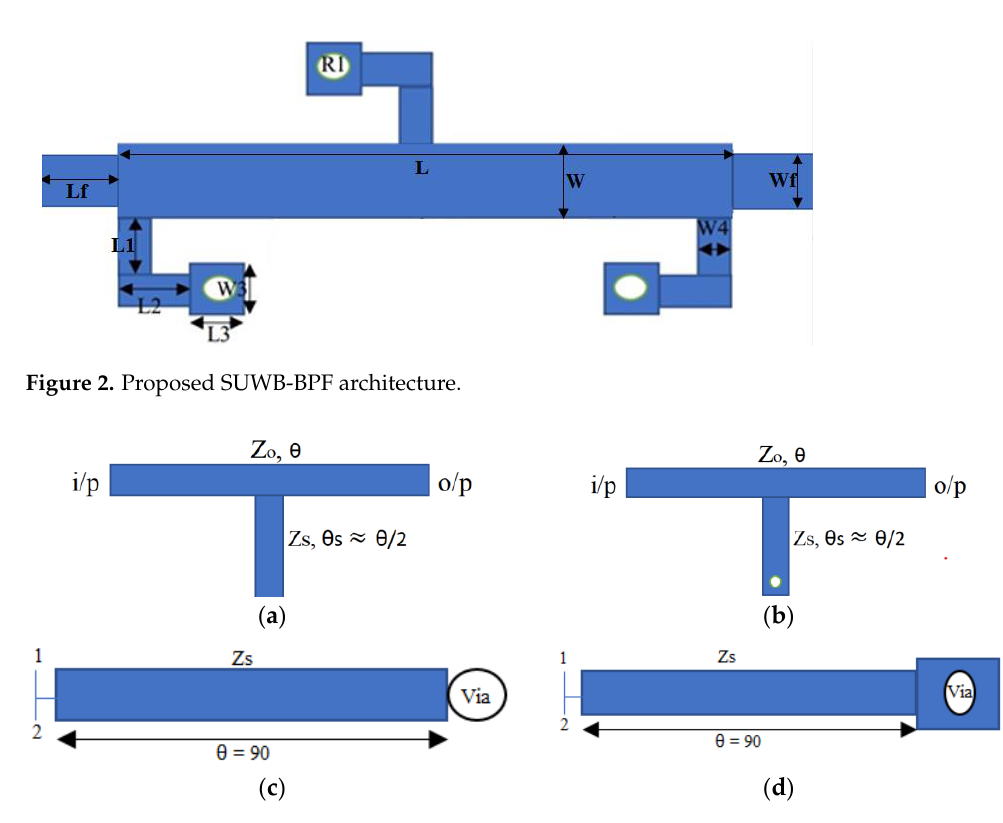
Figure 3. Stubs configurations: ( a ) open stub connected to UTL, ( b ) short-circuited stub connected to UTL, ( c ) conventional stub, and ( d ) the proposed shunt